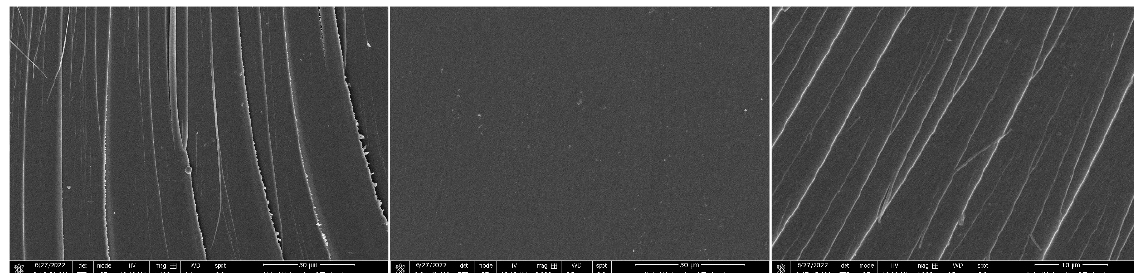
Figure 14. SEM of DPTP polymers.